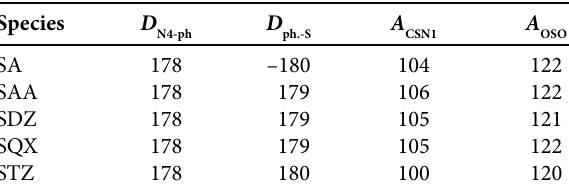
Table 1 . Dihedral and bond angles (in degrees) for SA species in neutral state at the B3LYP/6-311++G(d,p) level of theory. Species D N4-ph